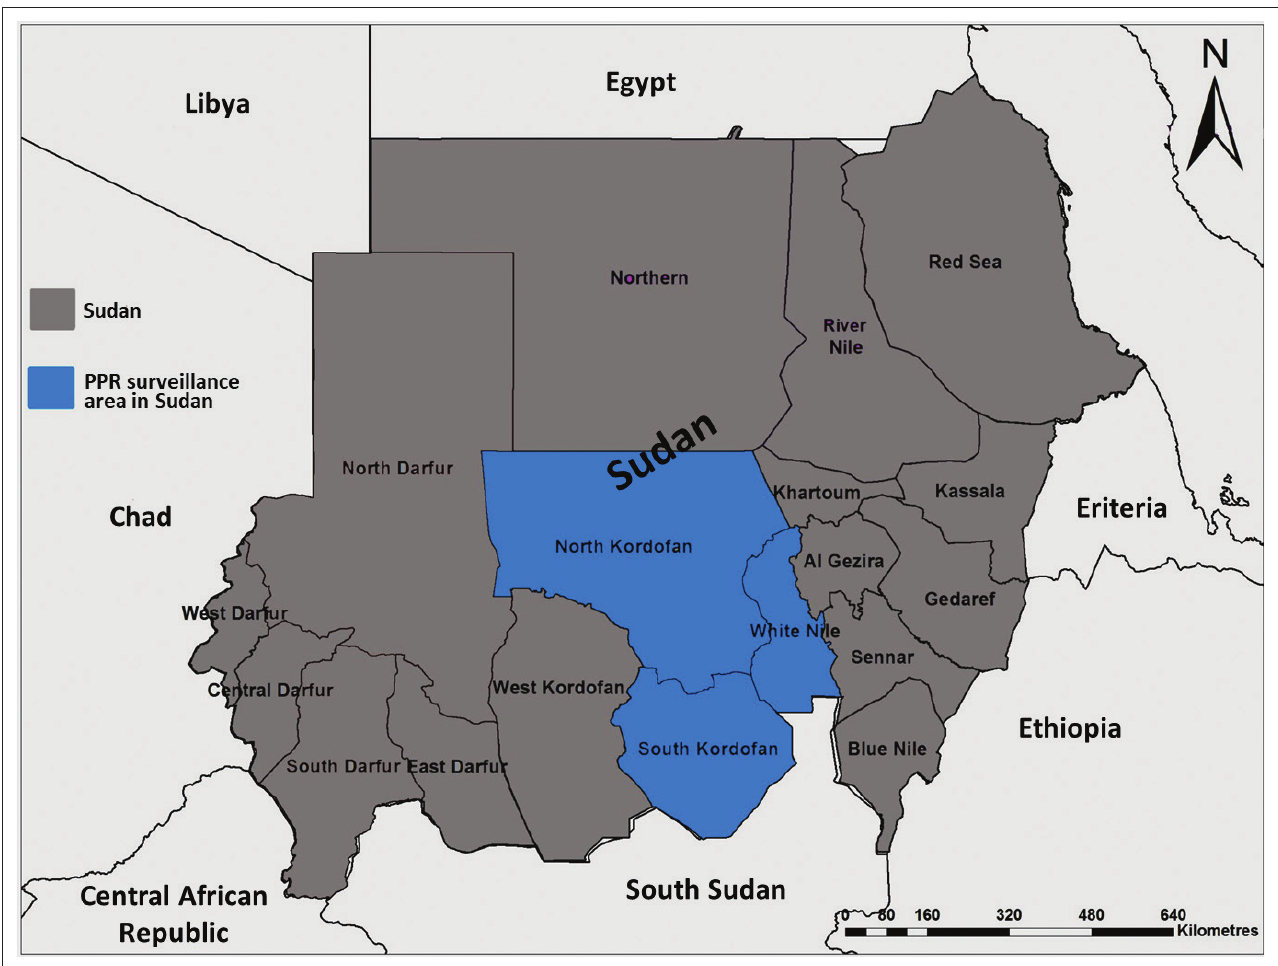
FIGURE 1: Locations of serological investigations of peste des petits ruminants in White Nile and Kordofan States,